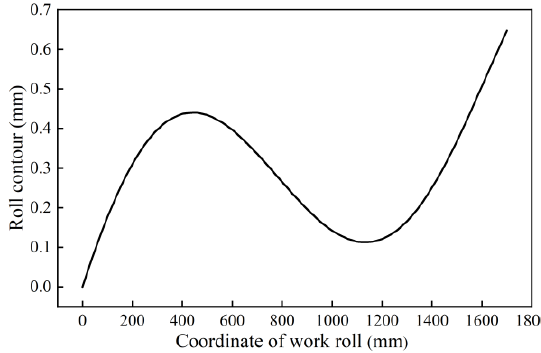
Figure 2. Work roll contour.